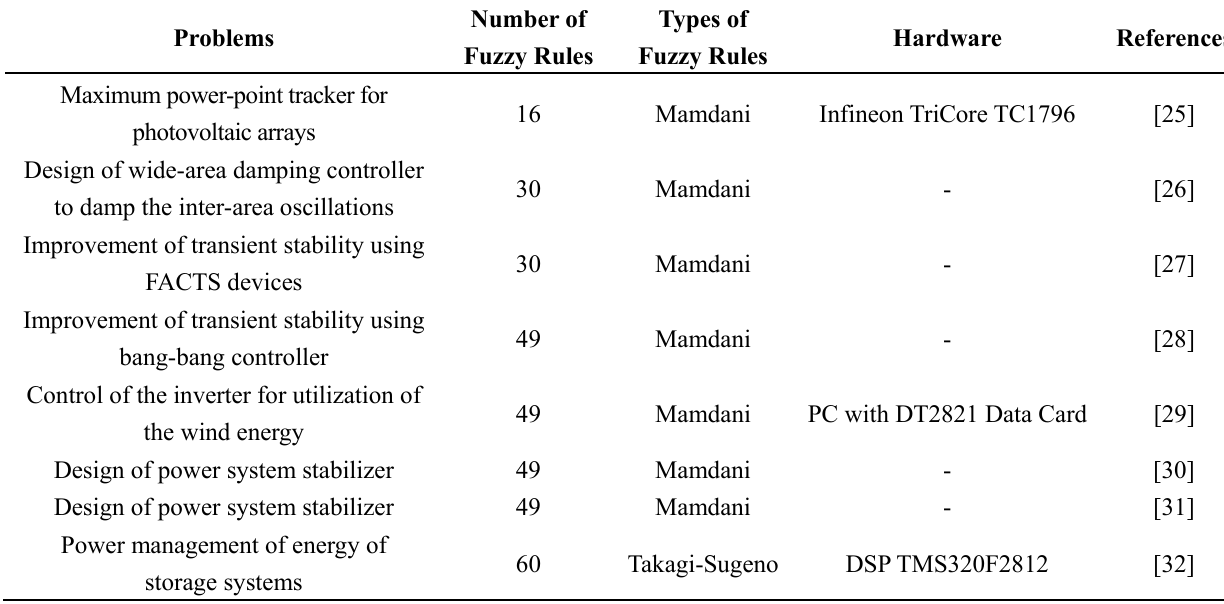
Table 2. Eight fuzzy rule-based controllers and their corresponding